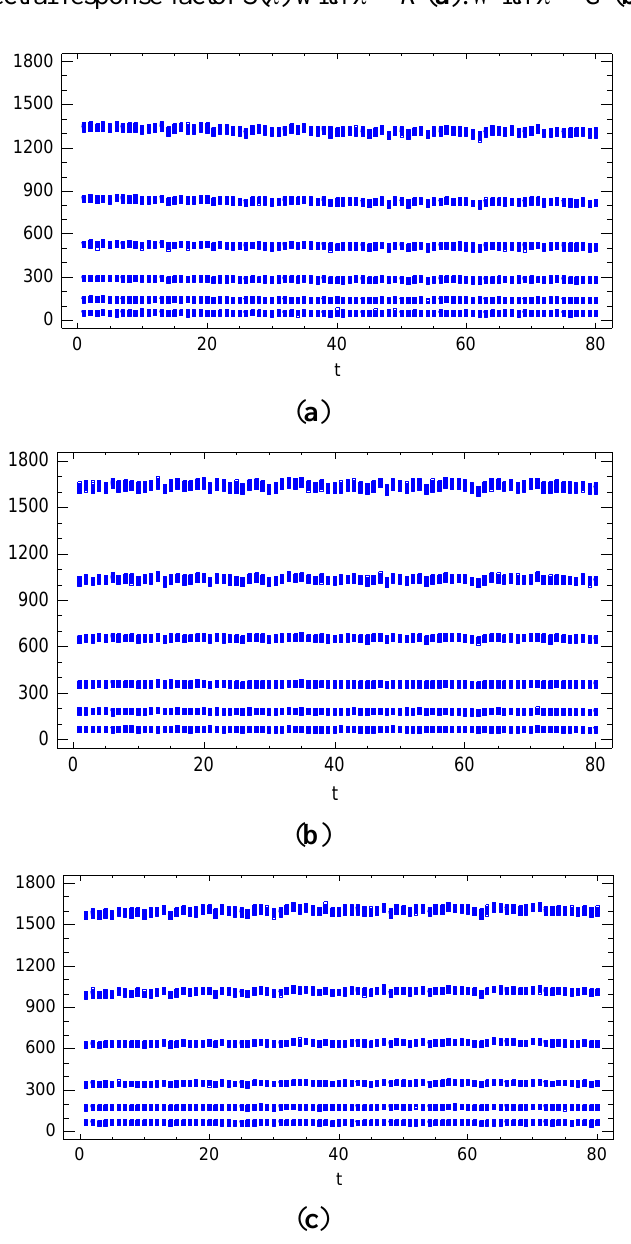
Figure 11. Temporal evolution of the radiometric values in the sequence of images. Evolution for the spectral response factor S ( λ ) with λ = R ( a ). With λ = G ( b ). With λ = B ( c